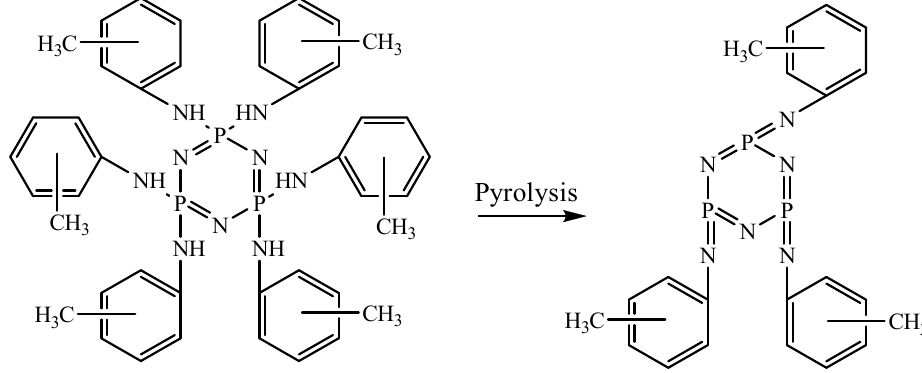
Figure 5. AAP pyrolysis flow circuit and the expected structure of the resulting product.